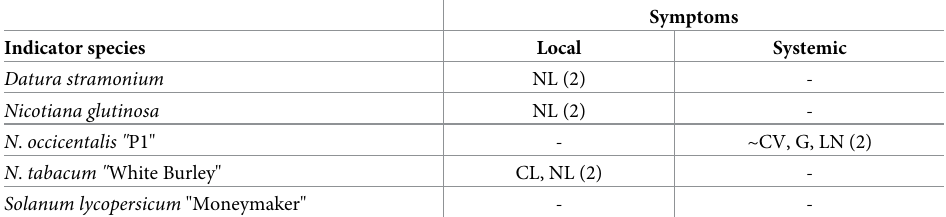
symptoms on the S . macrocarpon fruit could result from a viral infection, a homogenate of symptomatic tissue was inoculated on a range of test plants routinely used as indicators in virus diagnosis. The reaction on the inoculated test plants, six days post inoculation, indicated the presence of a tobamovirus (Table 1). Therefore, symptomatic leaves of N . occidentalis P1 were tested for different tobamoviruses by DAS-ELISA. Reactions were clearly positive for Table 1. Symptomatology of indicator plants inoculated with the homogenate from the intercepted S . macrocar- pon fruit. Symptoms Indicator species Local Systemic Datura stramonium NL (2)